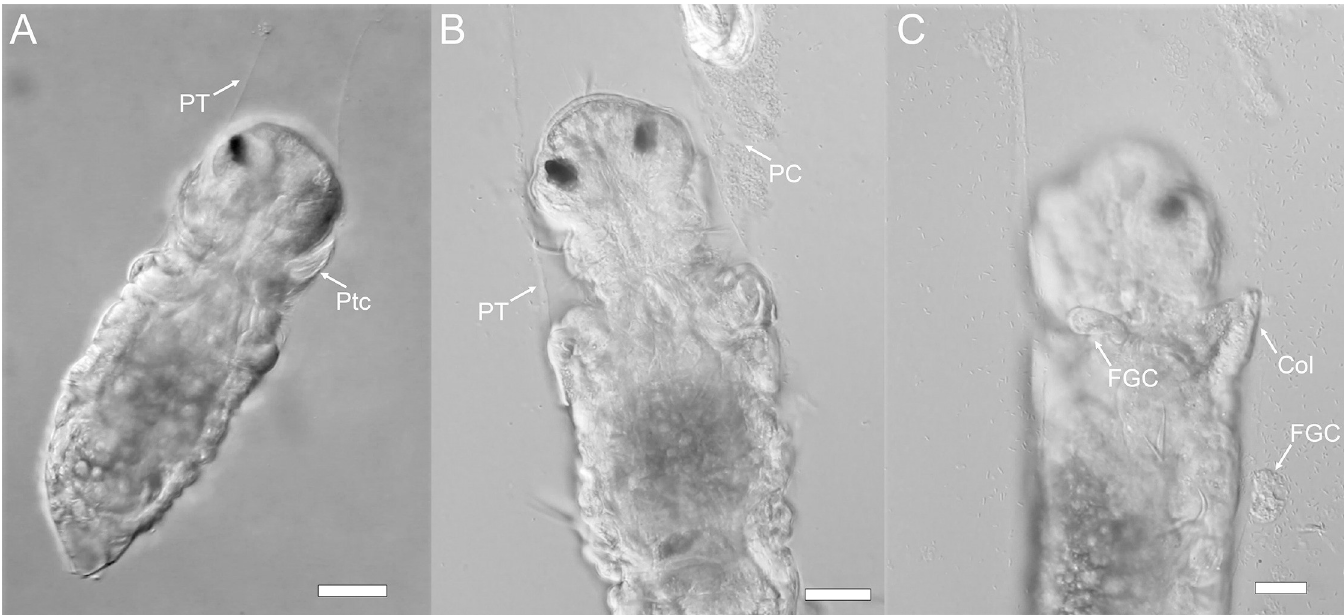
Fig 3. Sequence of metamorphic events in competent larvae of H . elegans exposed to a natural biofilm. A) Prototroch cilia are still attached when primary tube begins to form; B) Prototroch cilia shed while larva is in primary tube; C) Loss of food-groove cells and collar eversion. Scale bar: 20 μ m. Ptc, Prototroch cells; PT, Primary Tube; PC, shed Prototroch cilia; Col, collar; FGC, food groove cells.